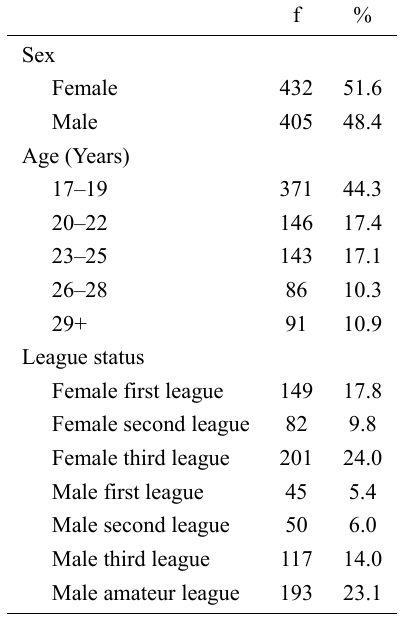
Table 1. Descriptive statistics for participants (n =